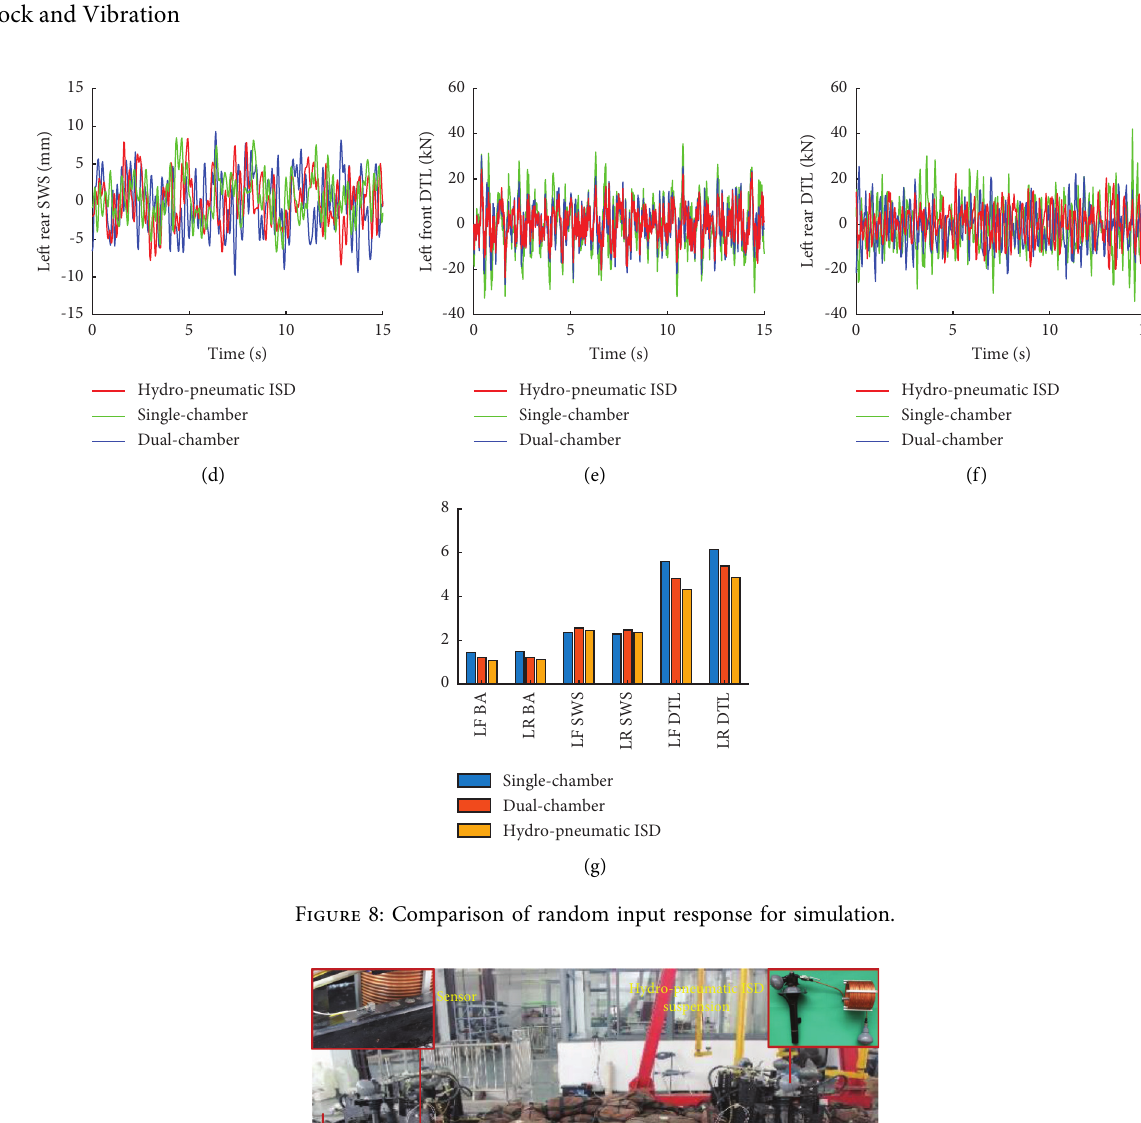
Figure 12, and the PTP values of test are presented in These results show that compared with the single- chamber hydro-pneumatic suspension, the PTP values of